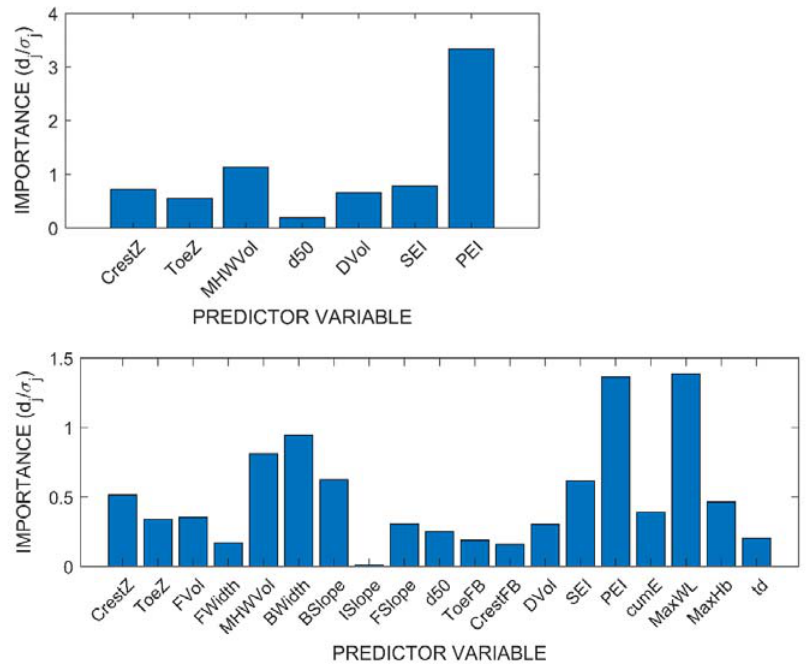
Figure 10. Predictor importance estimates based on classification tree ensemble using selected variables ( top ) and all initially tested variables ( bottom ).